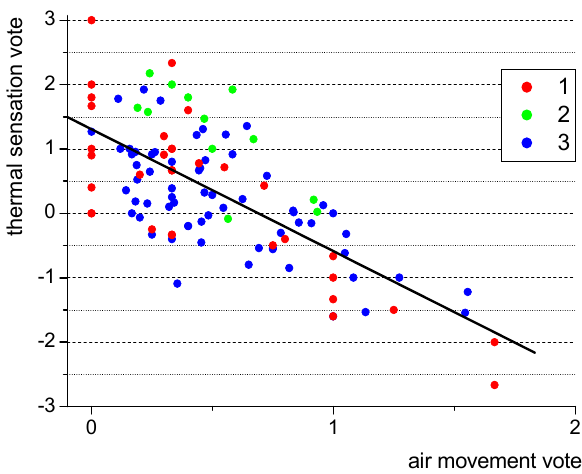
Figure 13. Thermal sensation vote vs. air movement: in the Courthouse (1), “A” building (2) and “Energies” (3) with the best fit linear approximation of all the data represented by the black line.